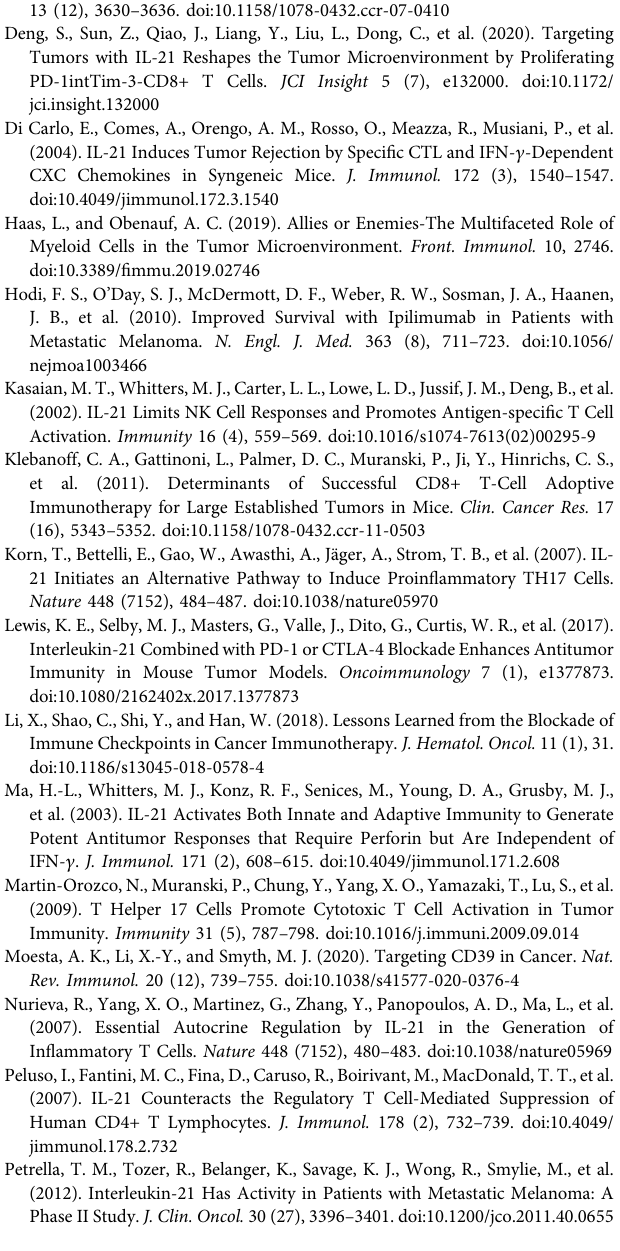
were injected intradermally to BALB/c mice, monitored tumor volume of tumorbearing mice treated with IgG, IL21, HSA-IL21, α -PD-1, HSA-IL21/ α -PD-1. (B) Individual tumor curves of mice depicted in Figure S2A. Data were presented as mean ± SEM, n (cid:2) 5, *p < 0.05, **p < 0.01, ***p < 0.001, ****p < 0.0001, two-way ANOVA test were performed. (C,D) MC38 tumor cells (1 × 10 6 ) were injected intradermally to B6 mice, monitored tumor volume (C) and individual tumor curves (D) of tumor-bearing mice treated with IgG, rIL21, HAS-IL21. Data were presented as mean ± SEM, n (cid:2) 5, *p < 0.05, **p < 0.01, ***p < 0.001, ****p < 0.0001, twoway ANOVA test were performed. Supplementary Figure S3 | Administration with Tim-3 or Lag-3, PD-1 mAbs and HSA-IL21 additively inhibited the tumor growth. (A – C) Individual tumor curves of mice depicted in Figures 8A,C,E